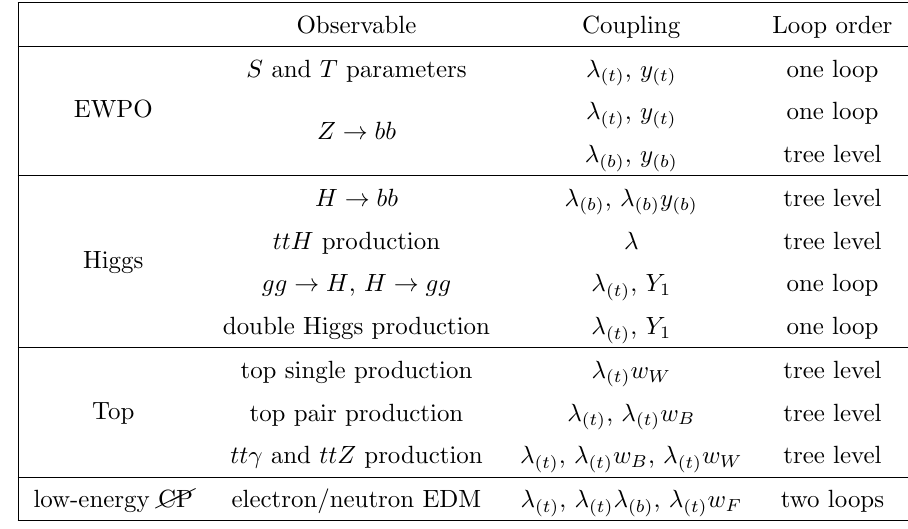
Table 3 . Summary of indirect e(cid:11)ects of heavy quarks. The subindex ( q ) means that only the couplings to the Standard Model quark q should be taken. The dependence on products of couplings may involve complex conjugation of some of